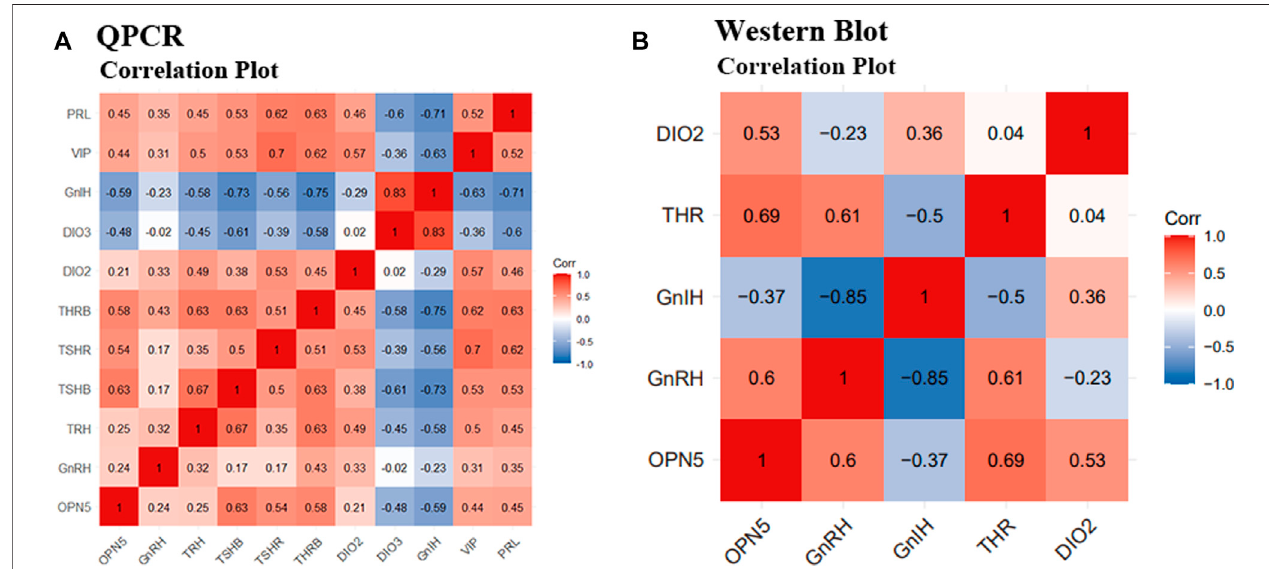
FIGURE 7 | Correlation analysis between positive and negative regulatory factors of reproduction activities under different photoperiods. Correlation analysis of QPCRresults and Western Blot results. (A) indicates the correlation analysisofthegene results ofOPN5,GnRH, TRH, TSH β ,TSHR, THR β , DIO2, DIO3, GnIH, VIP,and PRL, respectively; (B) indicates the correlation analysis of the protein results of OPN5, GnRH, GnIH, THR, and DIO2,